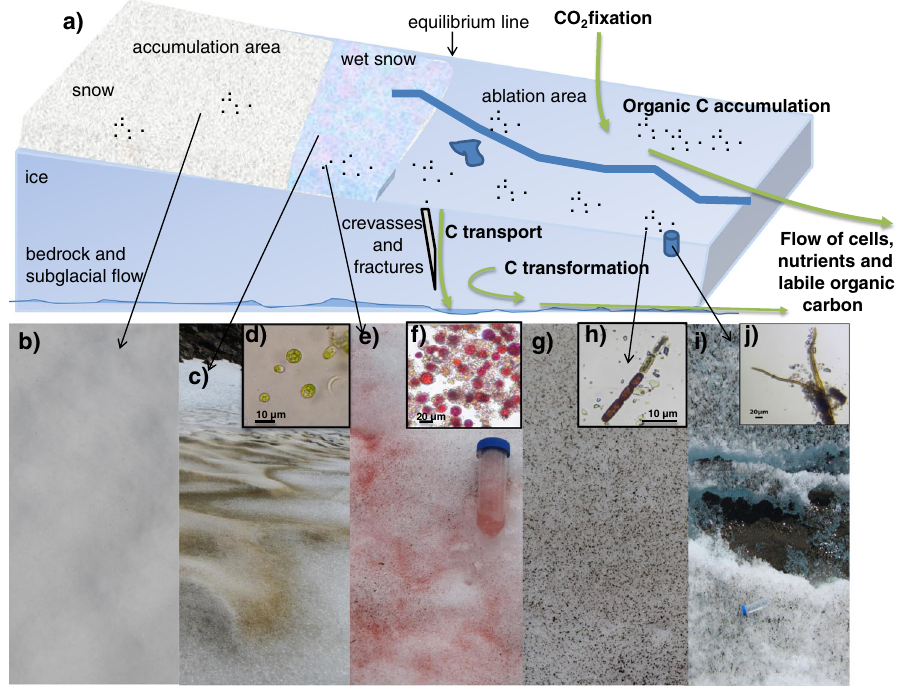
Fig. 2 a Schematic fi gure of the different glacial habitats for biological colonisation and activity with a closer view of the surface ecosystem. The signi fi cance of microbial activity in englacial and subglacial systems is still largely unknown; b white snow at the beginning of the melt season; c , d green snow with its dominant main primary producer (Chlamydomonadales) collected from a Svalbard glacier; e , f red snow with its dominant main primary producer (Chlamydomonadales) collected from a Svalbard glacier, g , h “ dirty ” ice with one of its dominant main primary producer (a Zygnematales); i , j an example of a cryoconite hole in the GrIS and one of its main primary producers ( Phormidesmis priestleyi